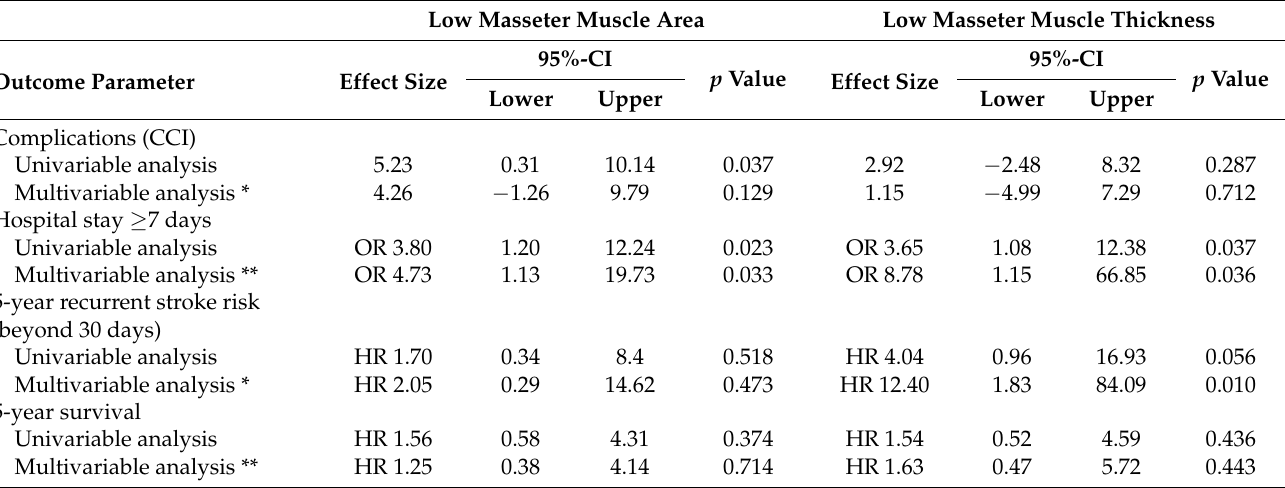
Table 3. Univariable and multivariable linear and logistic regression analysis of the association between low masseter muscle area, low masseter muscle thickness, and surgical